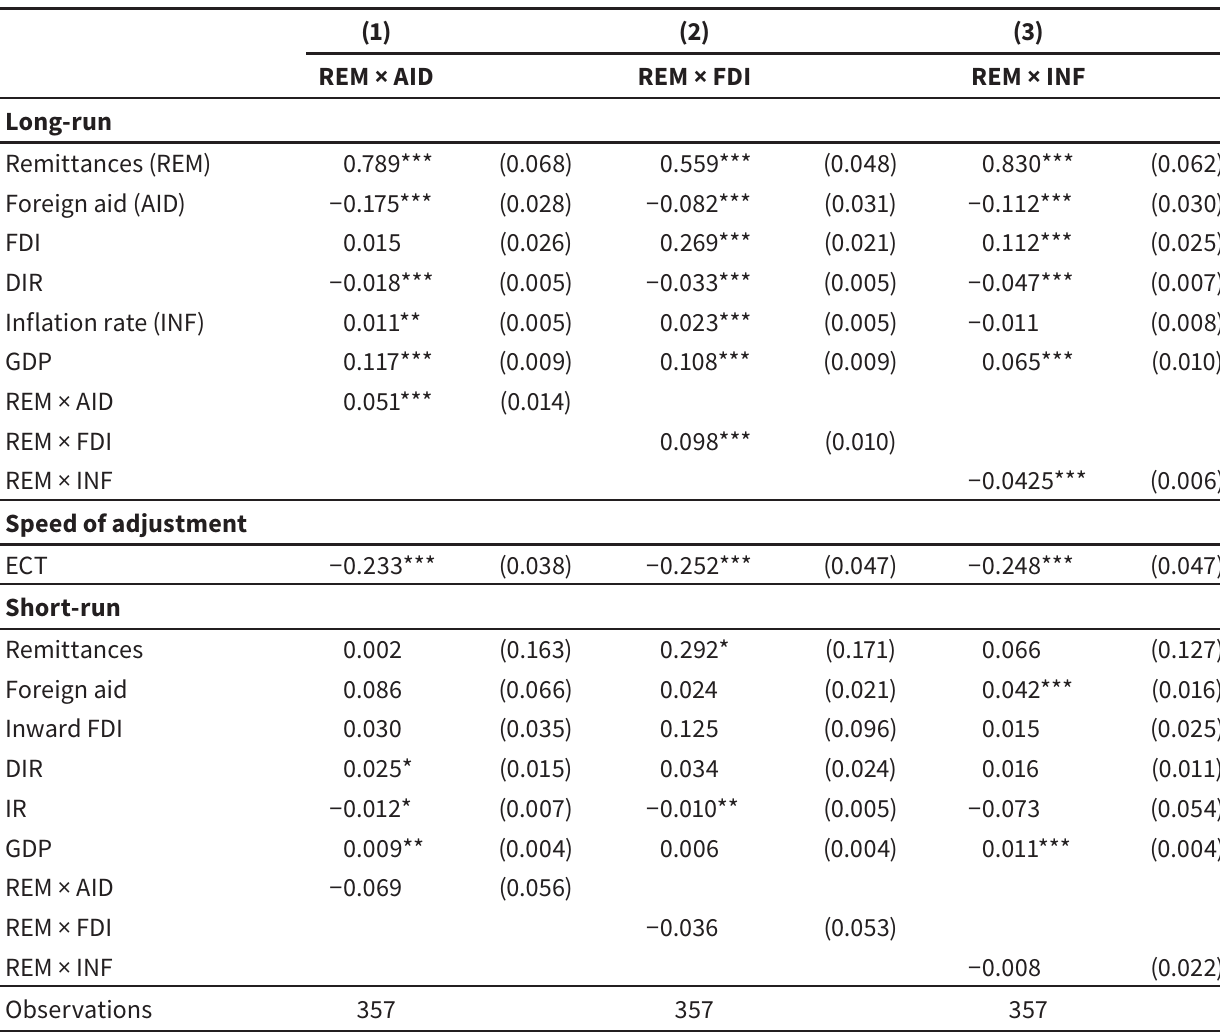
Interaction effects of foreign capital and macroeconomic environment on savings (1) (2) (3) REM ×